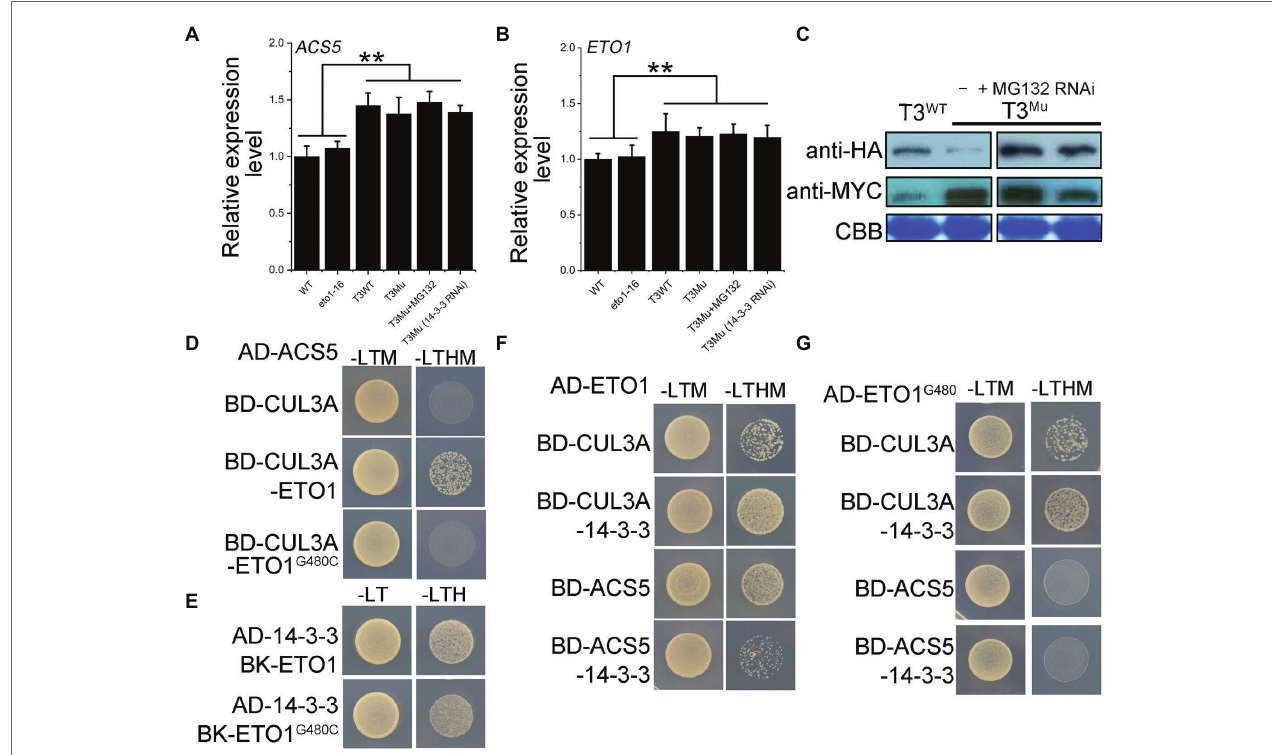
FIGURE 6 | Expression levels of ACS5 in WT and eto1-16 grown in a 16/8 h light/dark period, protein levels of HA-ETO1, HA-ETO1 G480C , and MYC-ACS5 in genetically modified plants grown in a 16/8 h light/dark period and the regulatory relationship among ETO1, ACS5, 14-3-3, and CUL3A proteins. (A) ACS5 expression levels in WT, eto1-16 , and T3 plants quantified by qRT-PCR. Error bars represent SEs. Student’s t -test (** p < 0.01). (B) ETO1 expression levels in WT, eto1-16 , and T3 plants quantified by qRT-PCR. Error bars represent SEs. Student’s t -test (** p < 0.01). (C) Protein levels of HA-ETO1, HA-ETO1 G480C , and ACS5 in plants T3 WT , T3 Mu , and T3 Mu following treatment of MG132 or 14-3-3 RNAi investigated by western blot. (D) Yeast three hybrid (Y3H) analysis by growth on auxotroph plate indicated the crucial role of ETO1 in linking the ACS5 and CUL3A. (E) Y2H analysis by growth on an auxotroph plate indicated the interaction of ETO1 G480C with 14-3-3. (F) Y3H assay among CUL3A, 14-3-3 and ETO1/ACS5 revealed the adverse roles of 14-3-3 in regulating ETO1 degradation and ACS5 stability. (G) Y3H assay results among CUL3A, 14-3-3, and ETO1 G480C